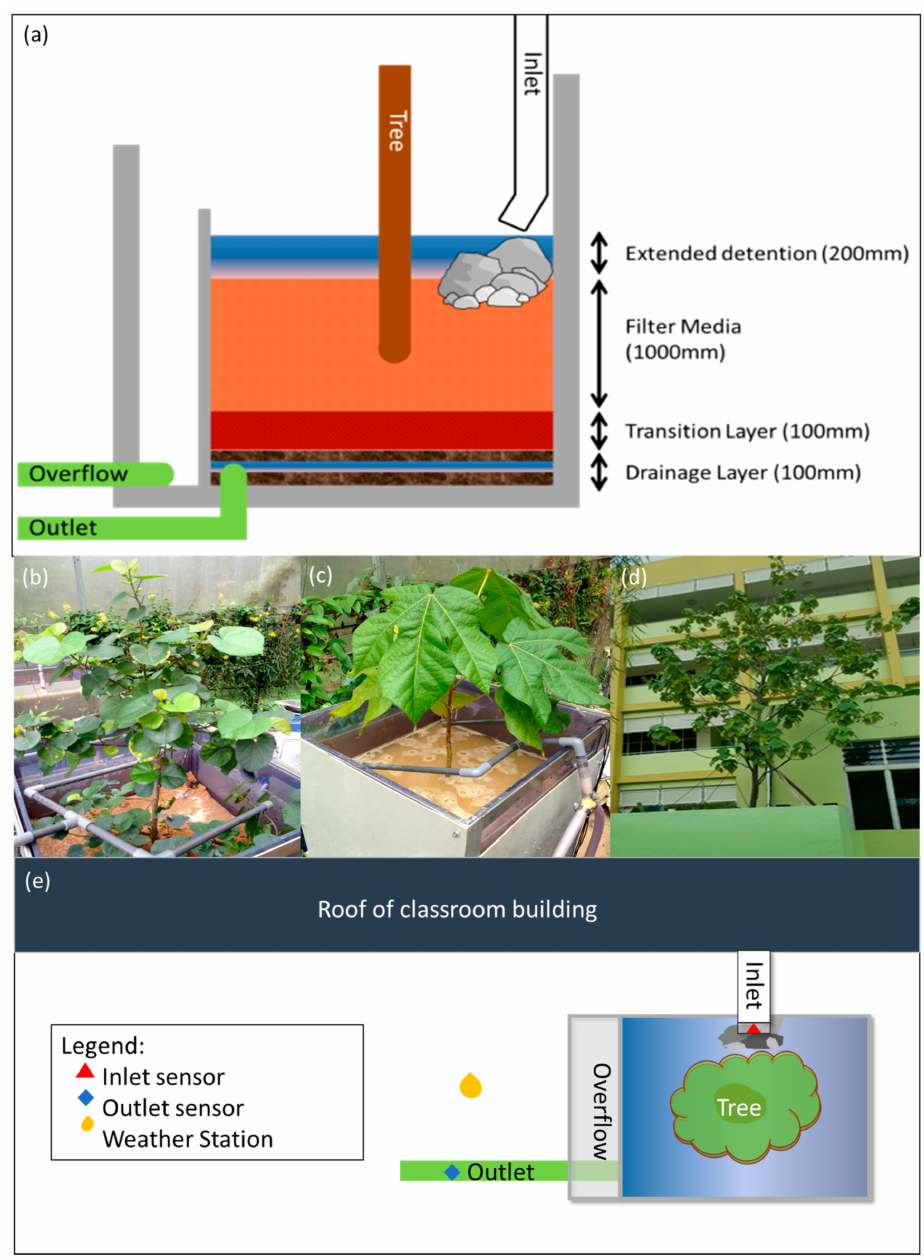
Figure 1. ( a ) Cross-sectional area for MBT system, ( b ) Talipariti tiliaceum used in the pilot study ( c ) Sterculia macrophylla used in the pilot study, ( d ) MBT system in the field study, ( e ) overview of MBT on